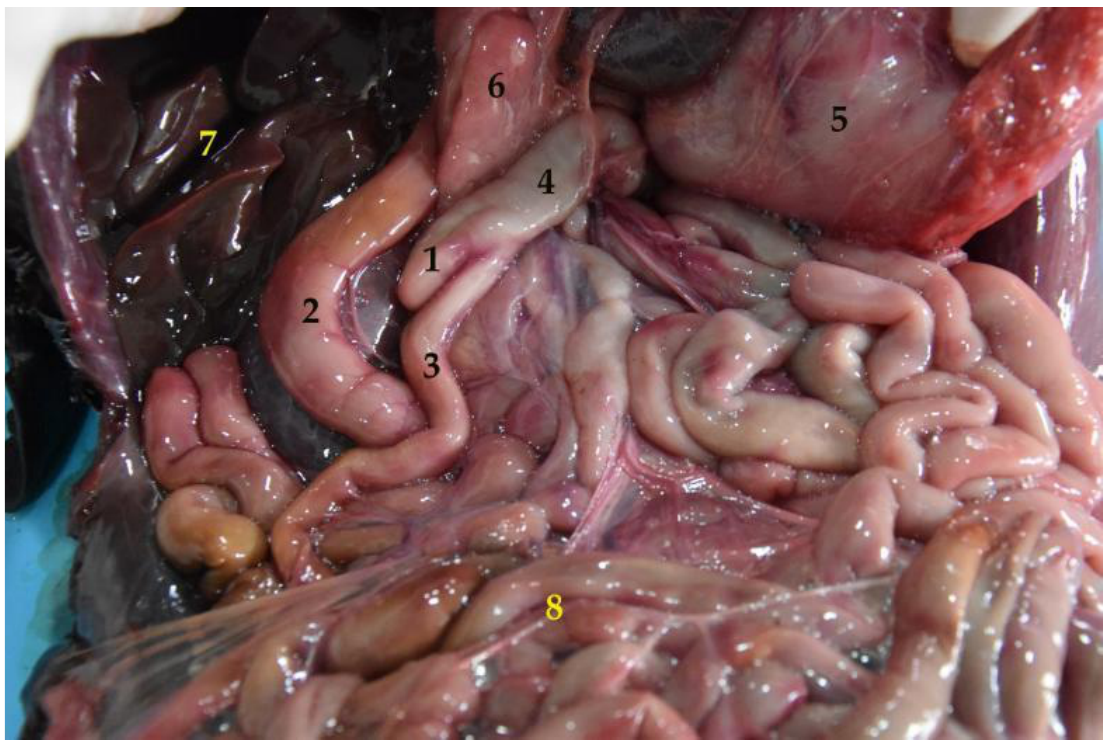
Figure 19. General view of the abdominal cavity (body in dorsal recumbency). The stomach is displaced to visualize the cecum in situ. ( 1 ) Cecum; ( 2 ) duodenum; ( 3 ) ileum; ( 4 ) colon; ( 5 ) stomach; ( 6 ) pancreas; ( 7 ) liver; ( 8 ) jejunum. The cecum of the South American fur seal is relatively small. In adults it measured 8.5 cm on average and 2.8 cm in juveniles (Table 5).